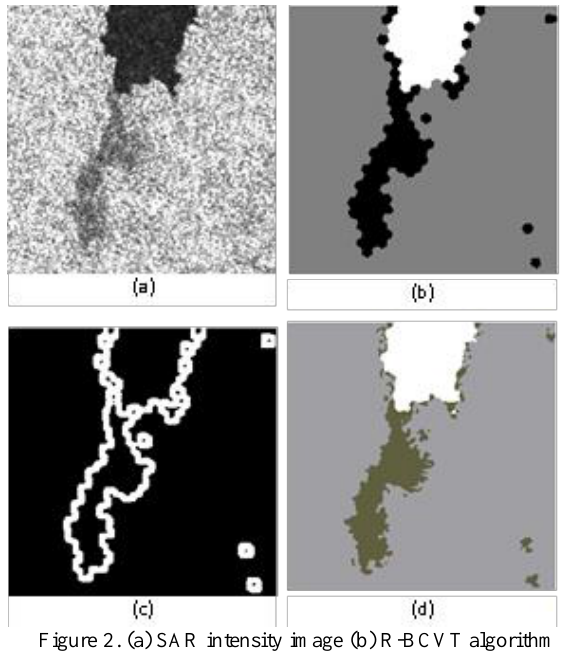
Figure 2. (a) SAR intensity image (b) R-BCVT algorithm outcome. (c) Buffer zone around the outlines of segmented image. (d) Refined segmentation image in buffer zone by use of k-mean clustering.